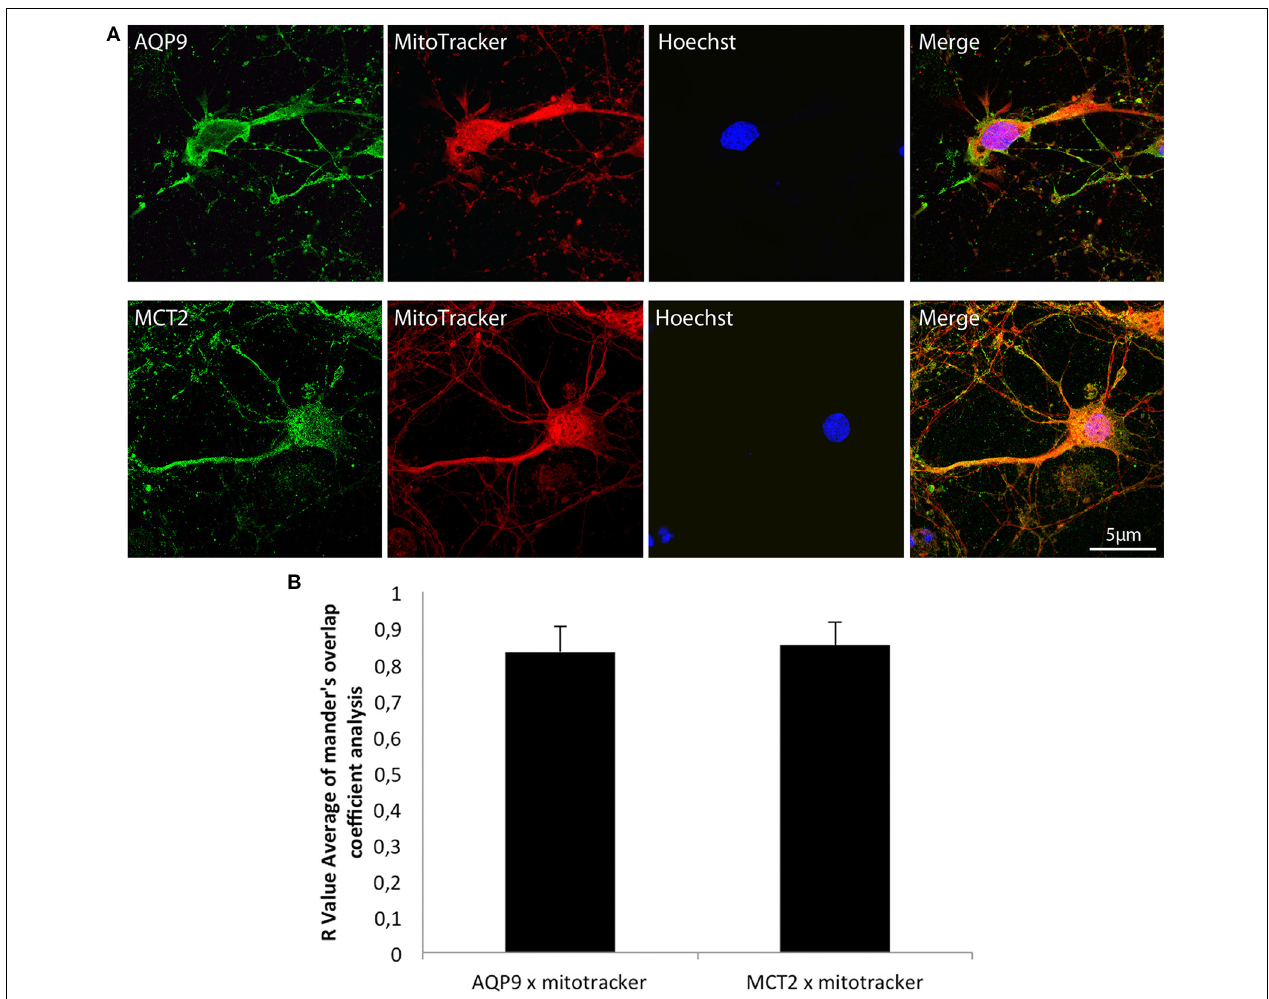
FIGURE 2 | Immunofluorescent localization of AQP9 and MCT2 in mitochondria of cultured rat hippocampal neurons (A) Immuno fluorescent labelings for AQP9 (in green, upper row) or MCT2 (in green, bottom row) and mitotracker staining (in red) in cultured rat hippocampal neurons. Colocalization between AQP9 or MCT2 and mitotracker appears as yellow on merged images (Merge). Nuclei (in blue)